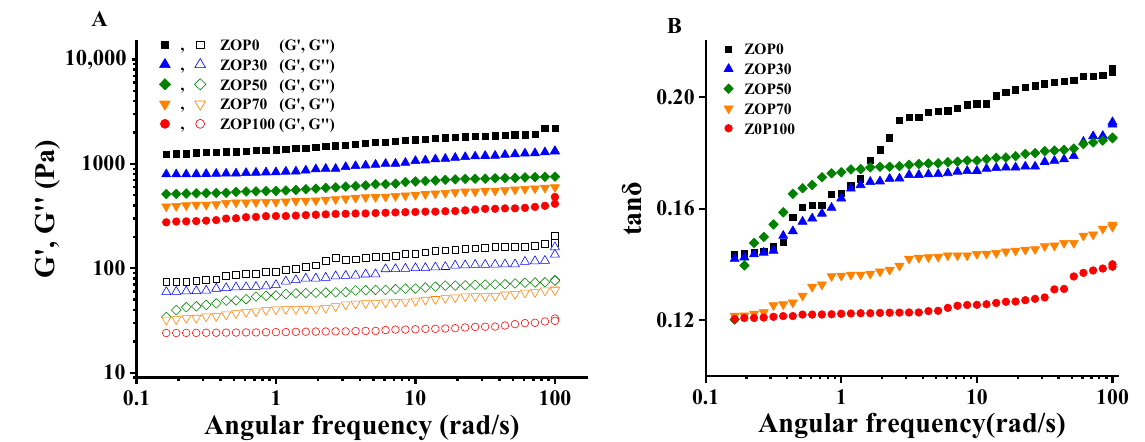
Figure 3. The storage modulus (G ′ ) and loss modulus (G ′′ ) curves of five gels, and the curves of tan δ of five gels changing with angular frequency. Table 1. Dynamic rheological parameters, gel hardness, and gel springiness of the